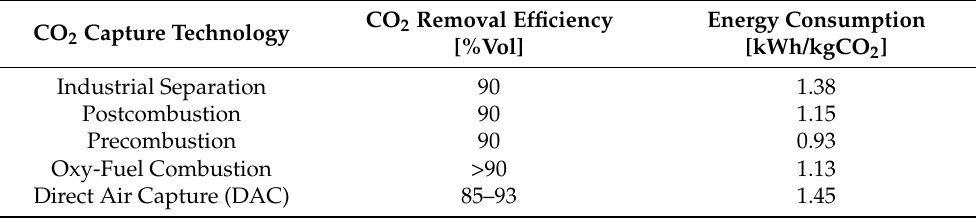
Table 9. Energetic performance of CO 2 capture technologies. Based on